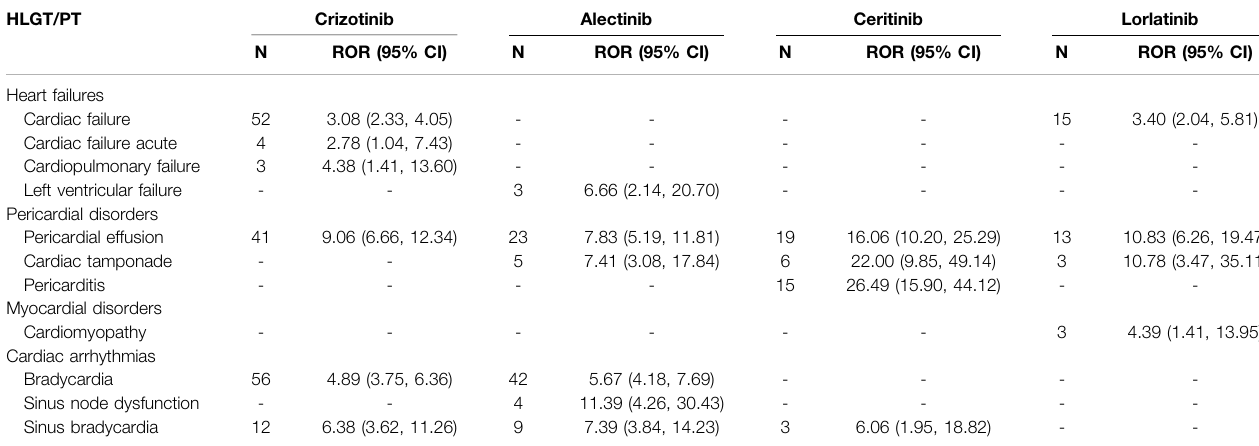
TABLE 4 | Positive signals of PT for ALK-TKI-associated cardiac disorders a . HLGT/PT Crizotinib Alectinib